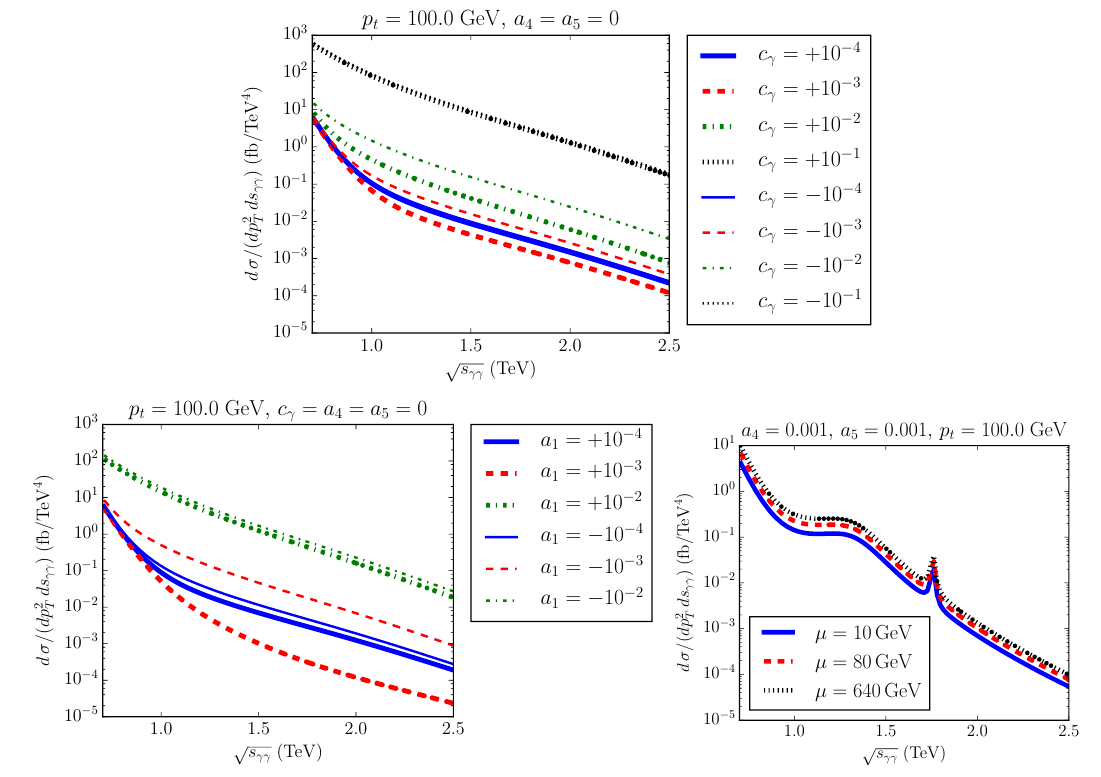
Figure 13 . Cross section for pp (cid:13)(cid:13)p (cid:3) p (cid:3) W L W L + X with di(cid:11)erent values of c (cid:13) (top) and a 1 ! ! (bottom-left). The bottom-right graph corresponds with a 2 = b = 0 : 95, a 4 = a 5 = 10 (cid:0) 3 . In all the cases, the LUX scale is (cid:22) = 640